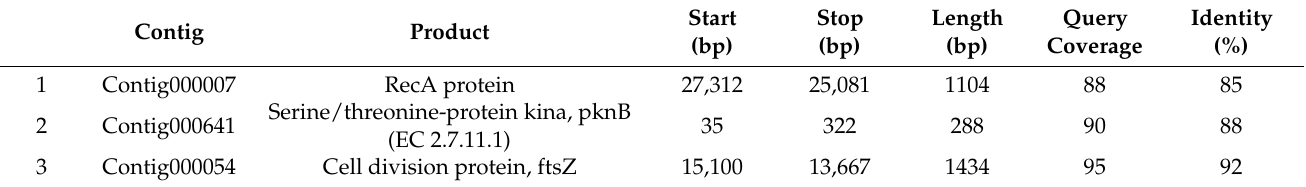
Table A3. Microtetraspora sp. AC03309 drug target gene identified using PATRIC server and DrugBank server. Contig Product